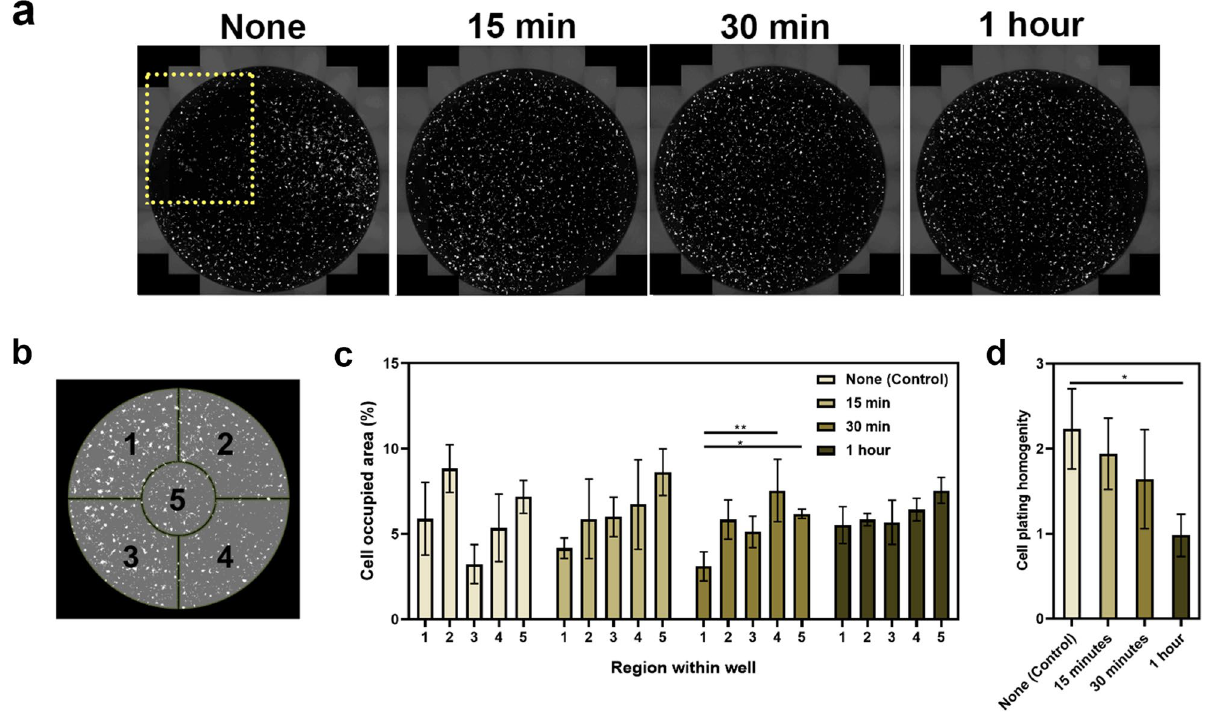
Figure 2. Different room temperature pre-incubation periods affect cell plating homogeneity across the well in 96-well plates. ( a ) Full well scan acquired using the full-well scan function on the EVOS FL Auto microscope with a ×10 objective lens. Yellow box indicates the region where cells are sparsely distributed. ( b ) Schematic illustration of well divisions into five regions for analysis. ( c ) Cell plating homogeneity was determined as the standard deviation between each region. This was used to evaluate the efficacy of pre-incubation for different time periods. Each bar represents the mean (n = 3) ± SD. ( d ) Cell plating homogeneity defined as the standard deviation between each region was used to evaluate the efficacy of pre-incubation for different time periods. Each bar represents the mean (n = 5) ± SD. A one-way ANOVA test and Tukey’s post-hoc analysis was performed to evaluate statistical significance where ** p < 0.01 and * p <